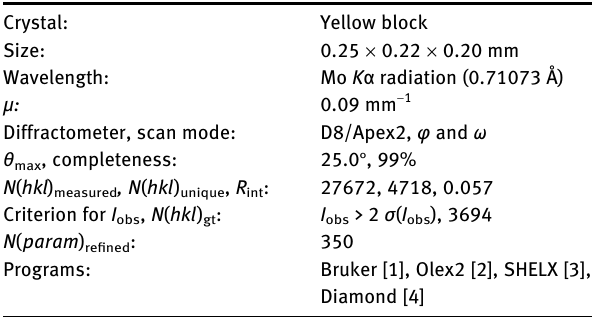
Table  : Data collection and handling. Crystal: Yellow